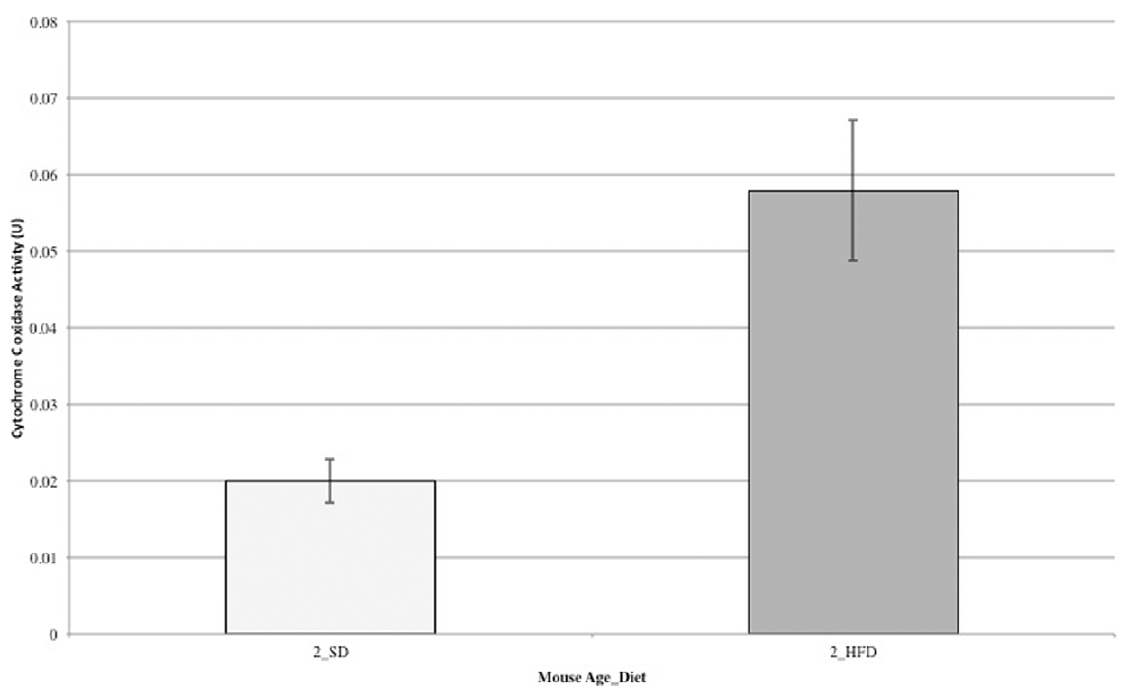
Figure 6. Comparison of cytochrome C oxidase activity between HFD- and SD-fed mice at two weeks, measured by an absorbance assay. The cytochrome C oxidase activity was measured for each skeletal muscle mitochondrial lysate from individual mice. Results show the mean + / 2 standard error. A single outlier for both HFD- and SD-fed mouse groups was removed. The fold change closely correlates with the fold change for COX41 measured by ATP-ABP ( Figure 3 ).